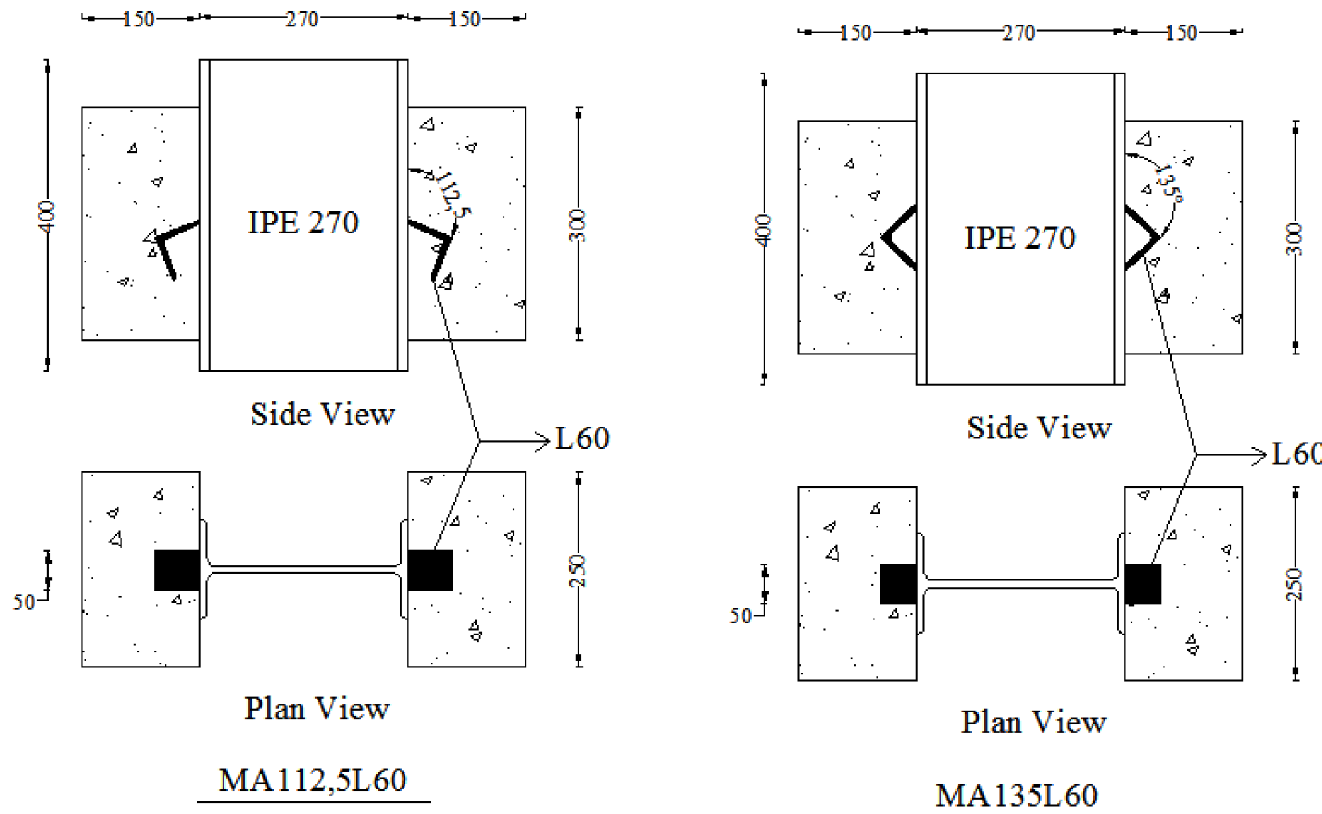
Fig 3. Schematic presentation of